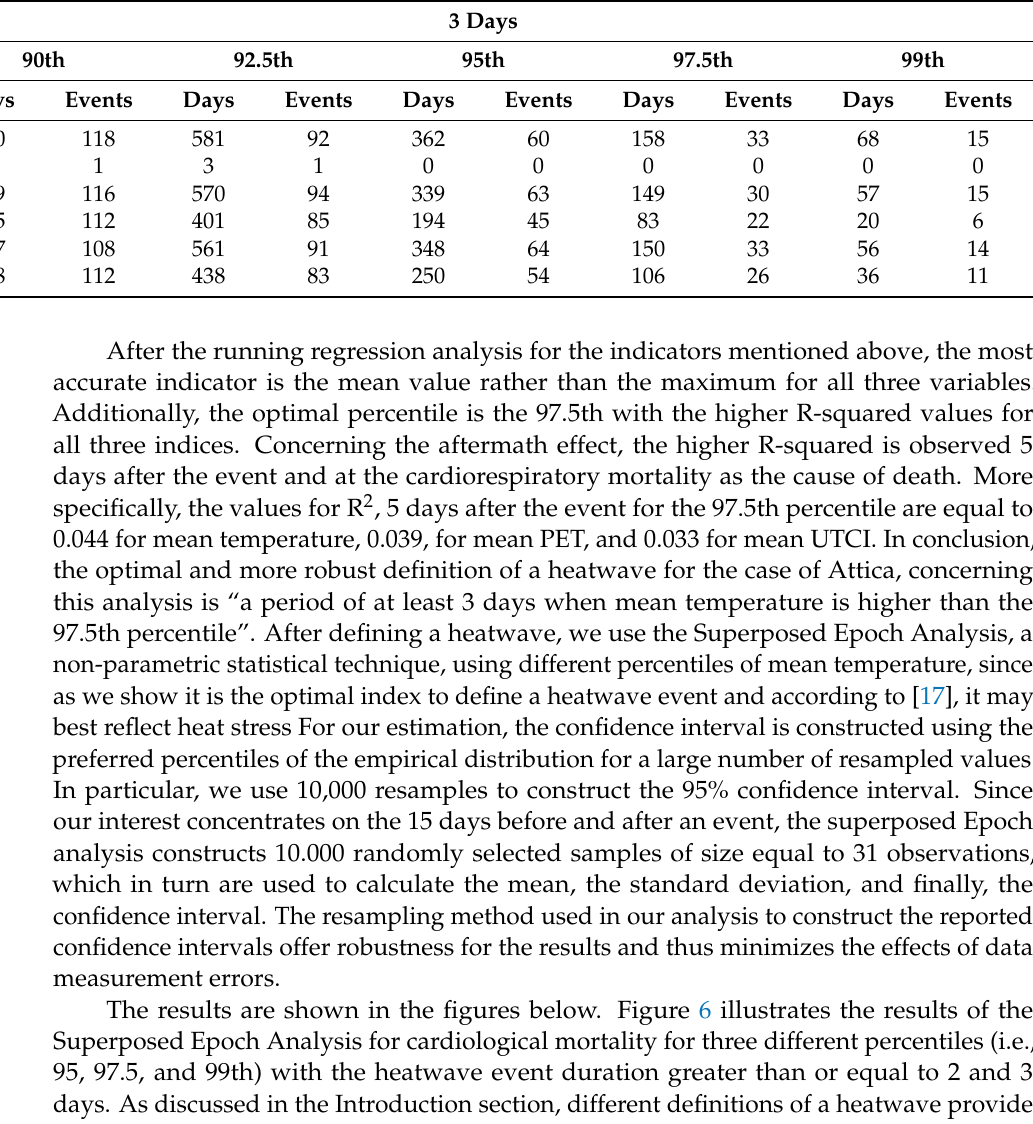
Table 4. Number of days and events for different percentiles for heatwave events (3